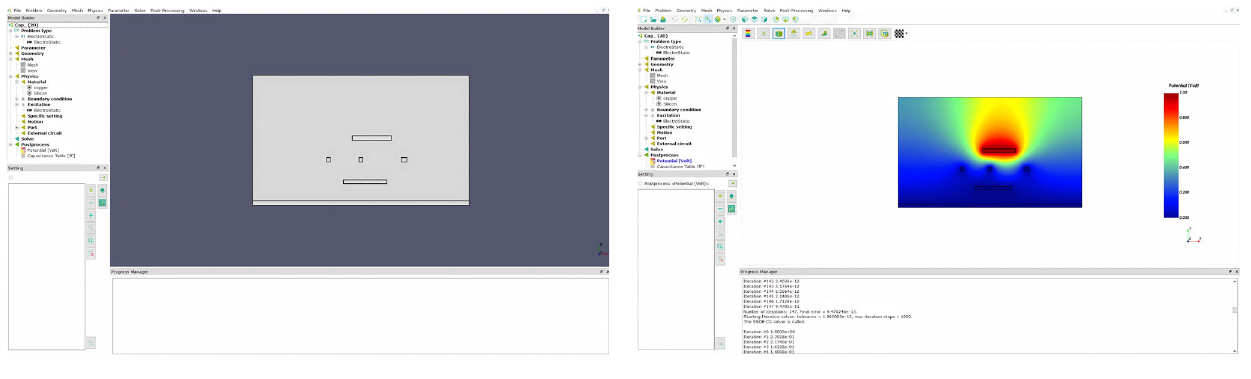
Figure 4. The model building and solving result interfaces of EMPbridge.